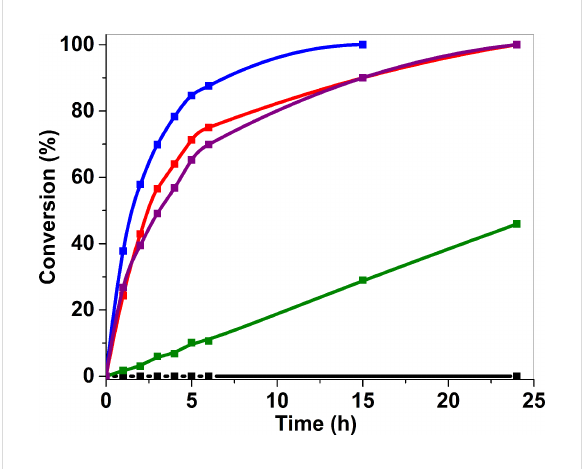
Figure 4: Monitoring over time of benzyl alcohol oxidative dehydroge- nation conversion with Au 25 (SG) 18 @ZrO 2 before calcination (black), after calcination at 200 °C for 4 hours under air, (A 200 ) (green), at 300 °C for 4 hours under air, (A 300 ) (blue), at 400 °C for 12 hours under air, (A 400 ) (red) and compared to AuNP@ZrO 2 (purple).